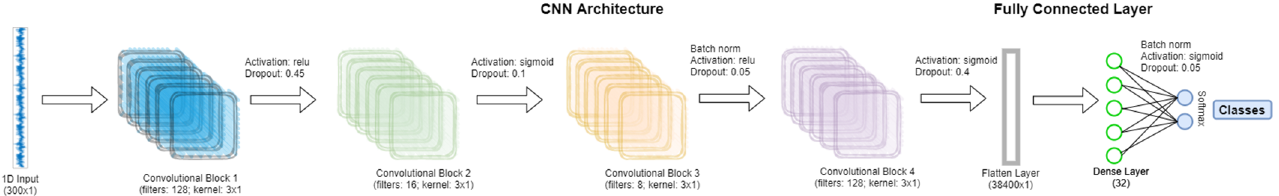
Figure 6. Best 1D CNN architecture produced by the NAS process.